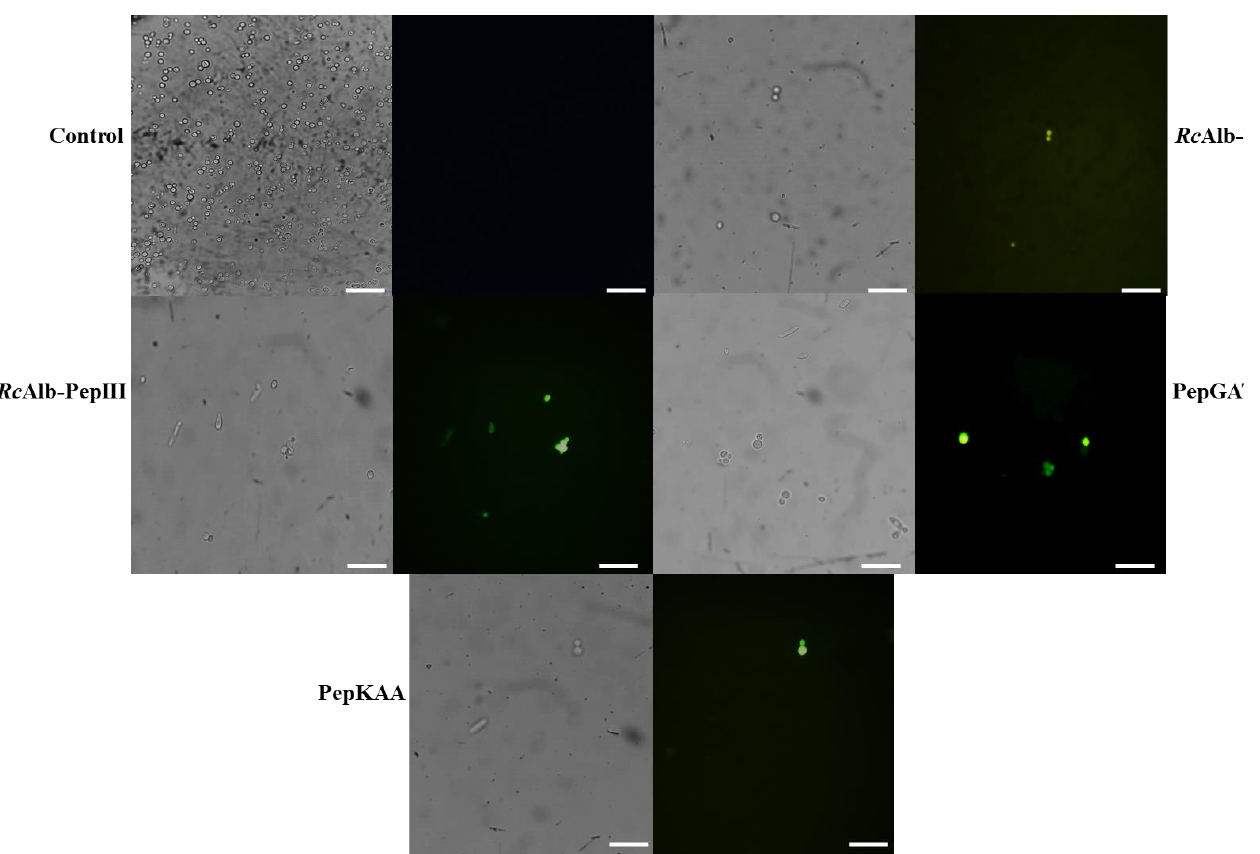
Figure 2. Hydrogen peroxide detection in C. neoformans cells. Green fluorescence revealed the overaccumulation of H 2 O 2 in C. neoformans cells induced by synthetic peptides. Control cells were treated with 5% DMSO in 0.15 M NaCl. Bars indicate 100 μm.